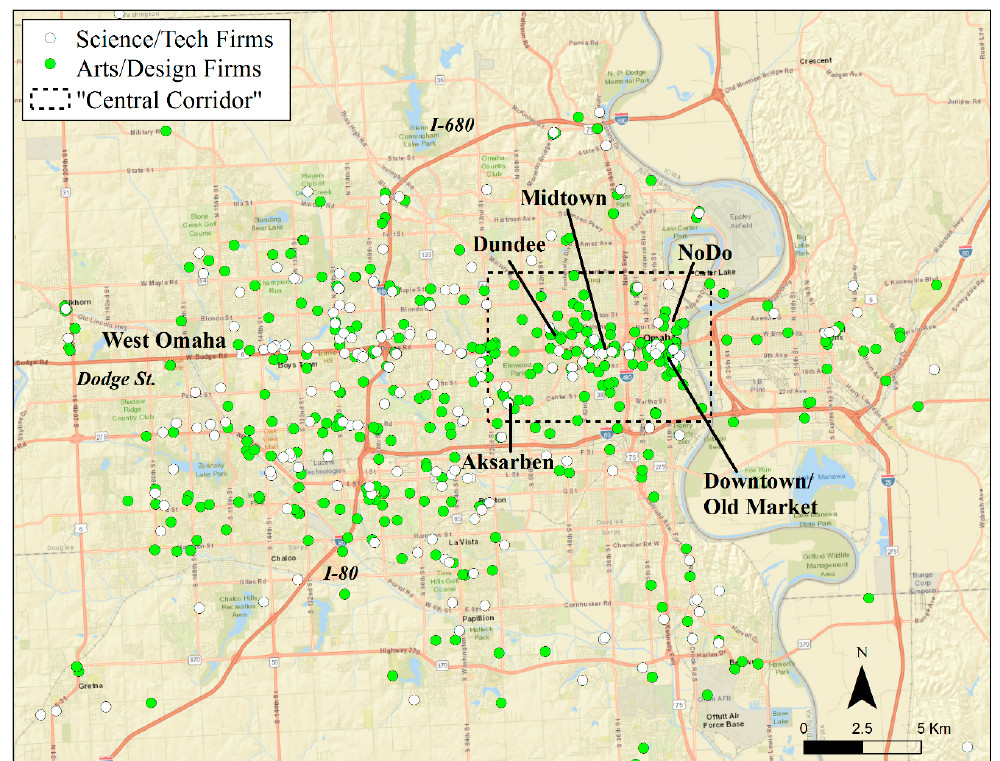
Figure 4. The location of arts/media firms and science/technology firms within the Omaha study area. Basemap courtesy of Esri™ [74].